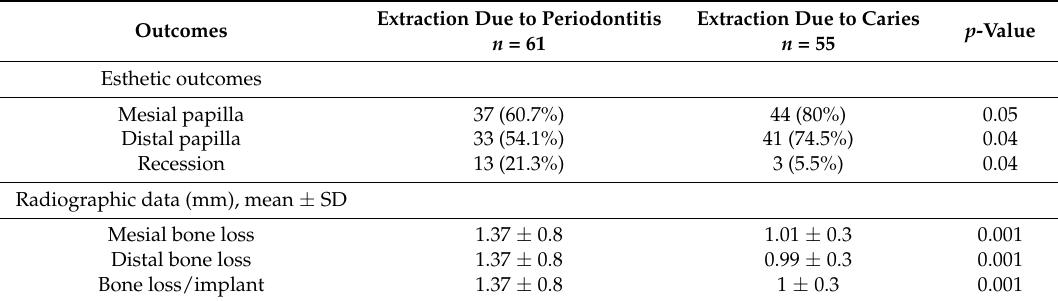
Table 4. Treatment outcomes per implant level. A comparison according to the reason for extractions between 61 implants in patients with periodontitis and 55 implants in patients with a caries